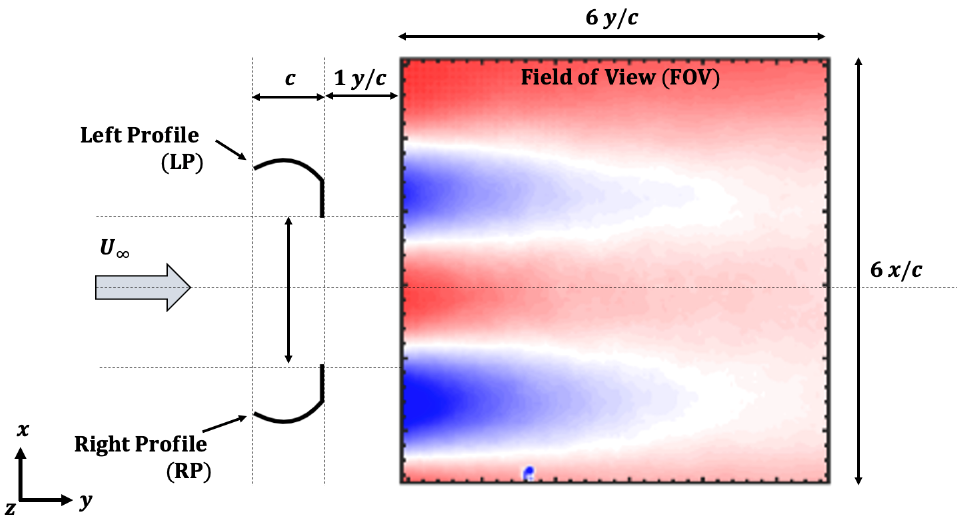
Figure 7. Location of PIV field of view behind two identical lens